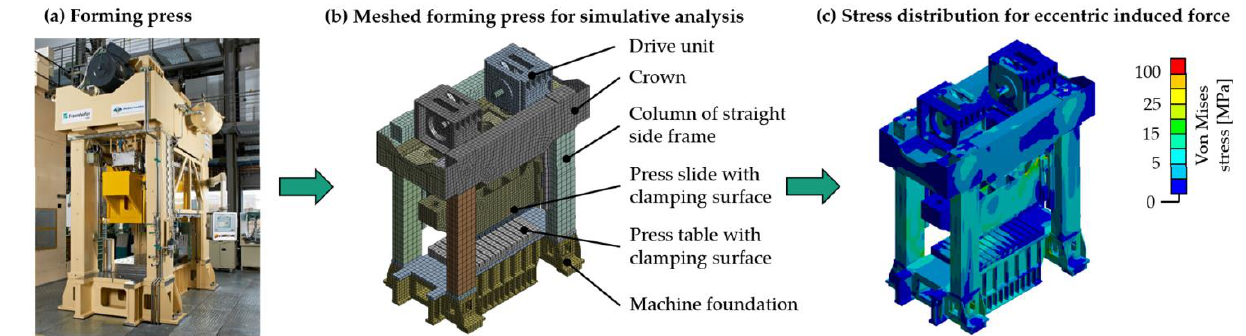
Figure 4. Simulative analysis to identify and describe the system interdependencies: ( a ) servo-eccentric press at Fraunhofer IWU, ( b ) development of FE model, and ( c ) simulated stress distribution for an eccentric load case.